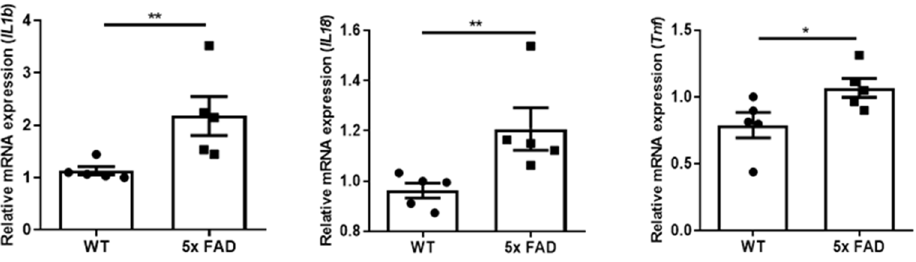
Figure 5. Increased pro-inflammatory cytokines in the FC of 5~6 mo 5 × FAD male mice . Increased mRNA levels of Il1b , Il18 , and Tn f were observed in the FC of older 5 × FAD mice (square dots) compared to WTs ( n = 5) (circle dots). Data expressed as mean ± SEM; * p < 0.05, ** p < 0.01 (Mann-Whitney test).